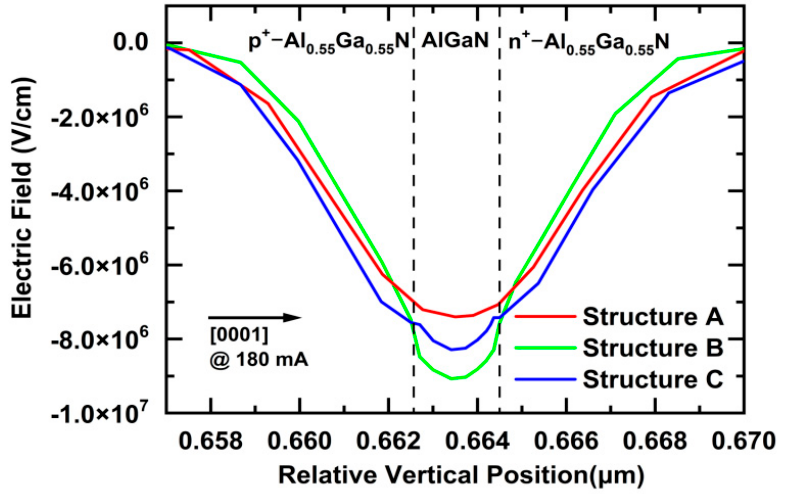
Figure 3. Comparison of the electric field profiles at a relative horizontal position of 100 µ m in the TJs of LEDs (300 × 300 µ m 2 ) in Structures A, B, and C at a current of 180 mA. Moreover, ε r has a role in controlling the intensity of E c , according to the expression in Equation (1). For AlGaN, ε r becomes small with an increase in the Al content of AlGaN. For Structure B, Al 0.4 Ga 0.6 N as the dielectric layer has a higher ε r than Structure A with Al 0.55 Ga 0.45 N, which should have decreased the intensity of E c . Nevertheless, an increased electric field is still obtained because of the contribution of a polarization-induced electric field in the center. For Structure C, Al 0.7 Ga 0.3 N as the dielectric layer has a lower ε r than Structure A with Al 0.55 Ga 0.45 N, which enhances the intensity of E c because of the contribution of ε r in the center. Thus, according to the final results regarding the contributions of E b , E p , and ε r , the intensities of E c are in the following order: Structure B > Structure C > Structure A in the center peak, and Structure C > Structure A > Structure B at both sides of the center, as shown in Figure 3. According to Figure 3, the calculated peak intensities of E c are as follows: E A = 7.40 × 10 6 V/cm, E × 10 6 V/cm, and E × 10 6 V/cm for Structures A, B, and B = 9.07 C = 8.24 C in the center peak, respectively. This means that very strong electric field intensities are generated in the TJ regions of the LEDs in Structures A, B, and C. Driven by E c , the electrons in the valence band of the p + -Al 0.55 Ga 0.45 N layer can tunnel through the TJ and inject themselves into the conduction band of the n + -Al 0.55 Ga 0.45 N layer. The holes